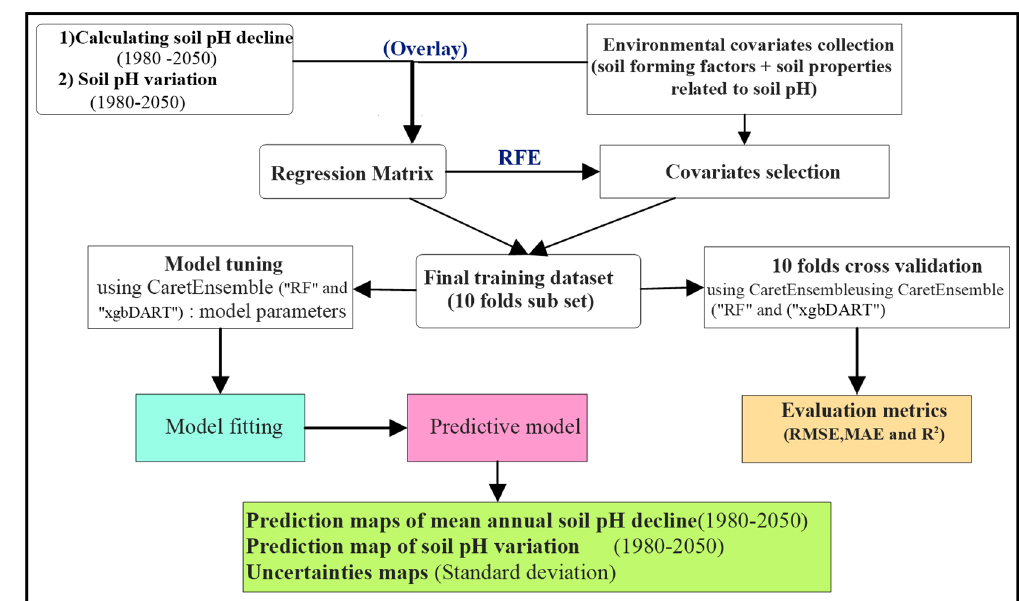
Figure 2. Spatial prediction workflow.